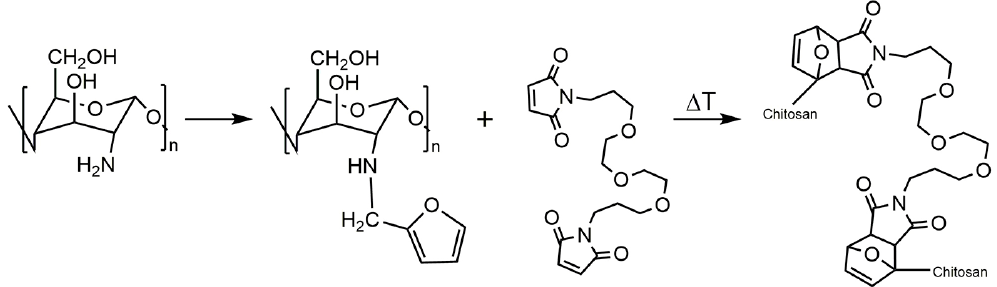
Figure 4. Synthetic scheme for the preparation of N -(furfural) chitosan by Schiff base formation/reductive amination process and Diels–Alder cycloaddition with a bismaleimide giving chitosan hydrogel.